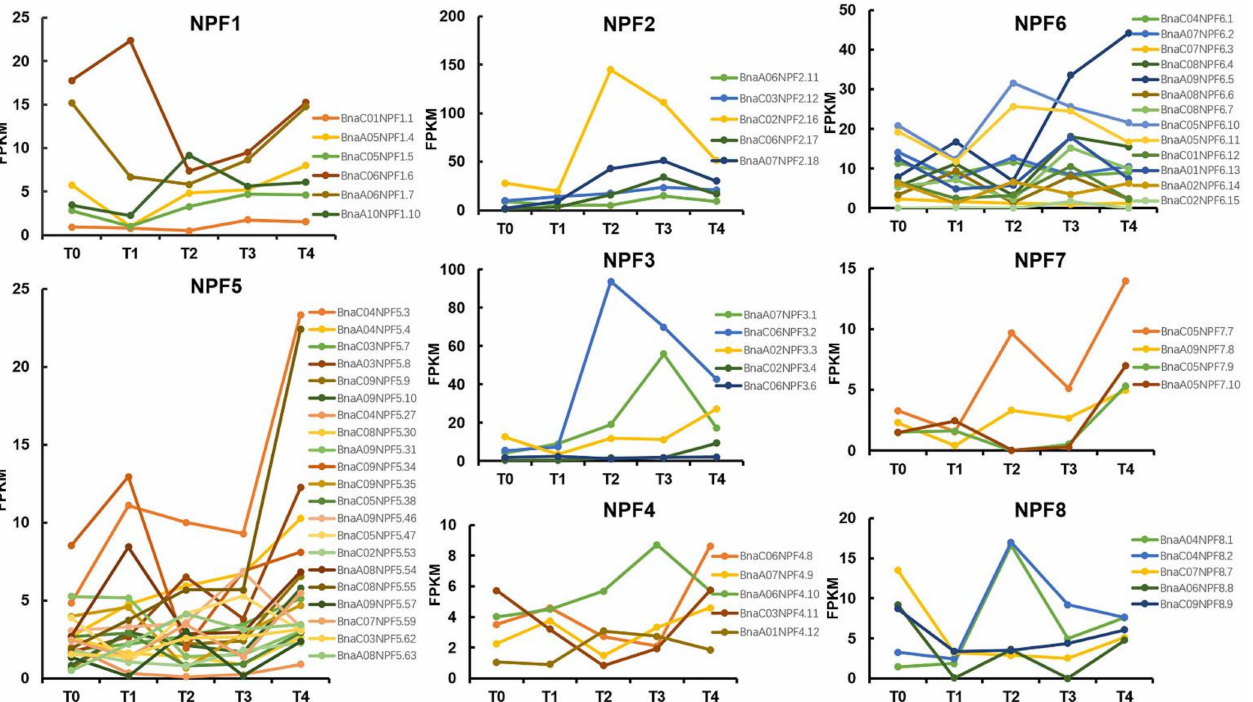
Figure 5. The expression changes of BnaNPF genes in leaves of ZS11 cultivar at five growth stages during vernalization. Plot FPKM value on the vertical Y -axis against growth stage on the horizontal x -axis. T0: 24 days post sowing and before vernalization; T1: 54 days post sowing and during vernalization; T2: 82 days post sowing and during vernalization; T3: 115 days post sowing and during vernalization; T4: 147 days post sowing and post